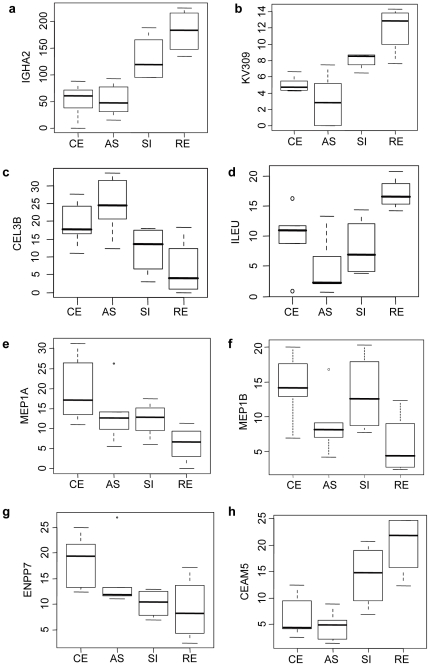
Boxplots of representative proteins with biogeographic features.The bottom and top of the boxes are the 25th and 75th percentile (the lower and upper quartiles, respectively), and the band near the middle of the box is the median. The whiskers present minimum to maximum value in the group. CE: cecum. AS: ascending colon. SI: sigmoid colon. RE: rectal colon. ANOVA is used for comparison between different regions. a. IGHA2 (P<0.001). b. KV309 (P<0.001). c. CEL3B (P = 0.017). d. ILEU (P = 0.017). e. MEP1A (P = 0.069). f. MEP1B (P = 0.044). g. ENPP7 (P = 0.014). h. CEAM5 (P<0.001).